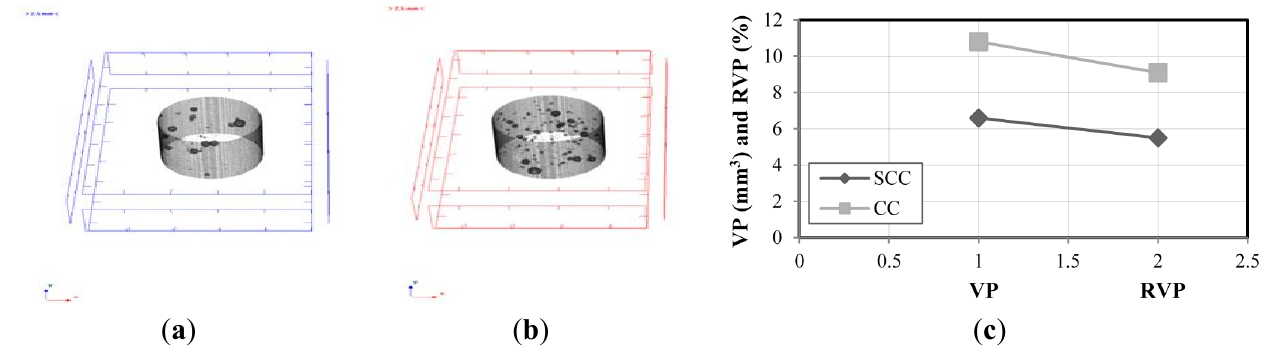
Figure 13. Results of the microtomography (MT) experiments. ( a ) SCC_Lab MT image; ( b ) CC_Lab MT image; ( c ) pore volume and total volume plot